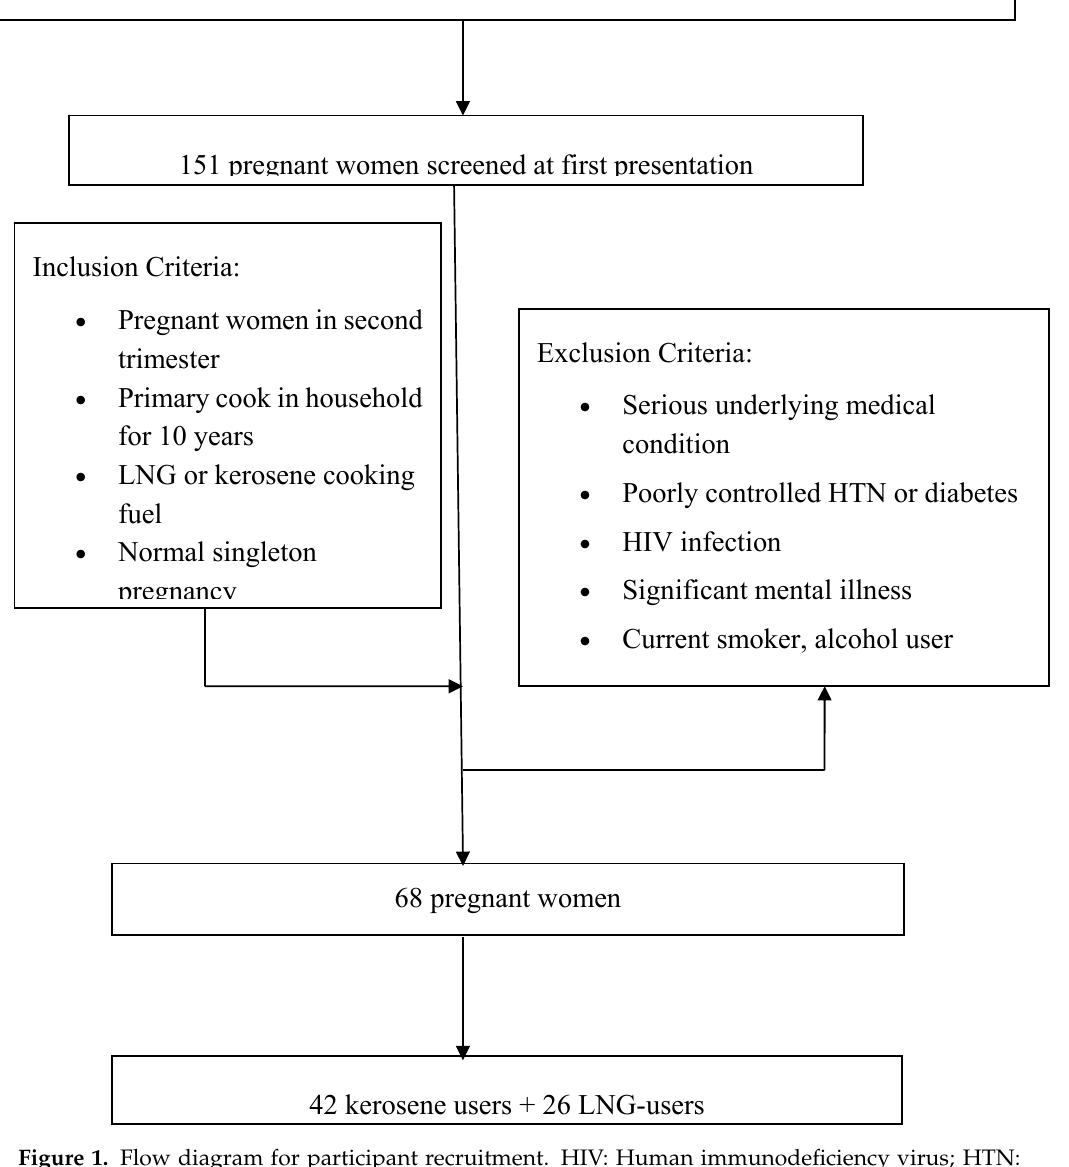
Figure 1. Flow diagram for participant recruitment. HIV: Human immunodeficiency virus; HTN: hypertension; LNG: liquefied natural gas.